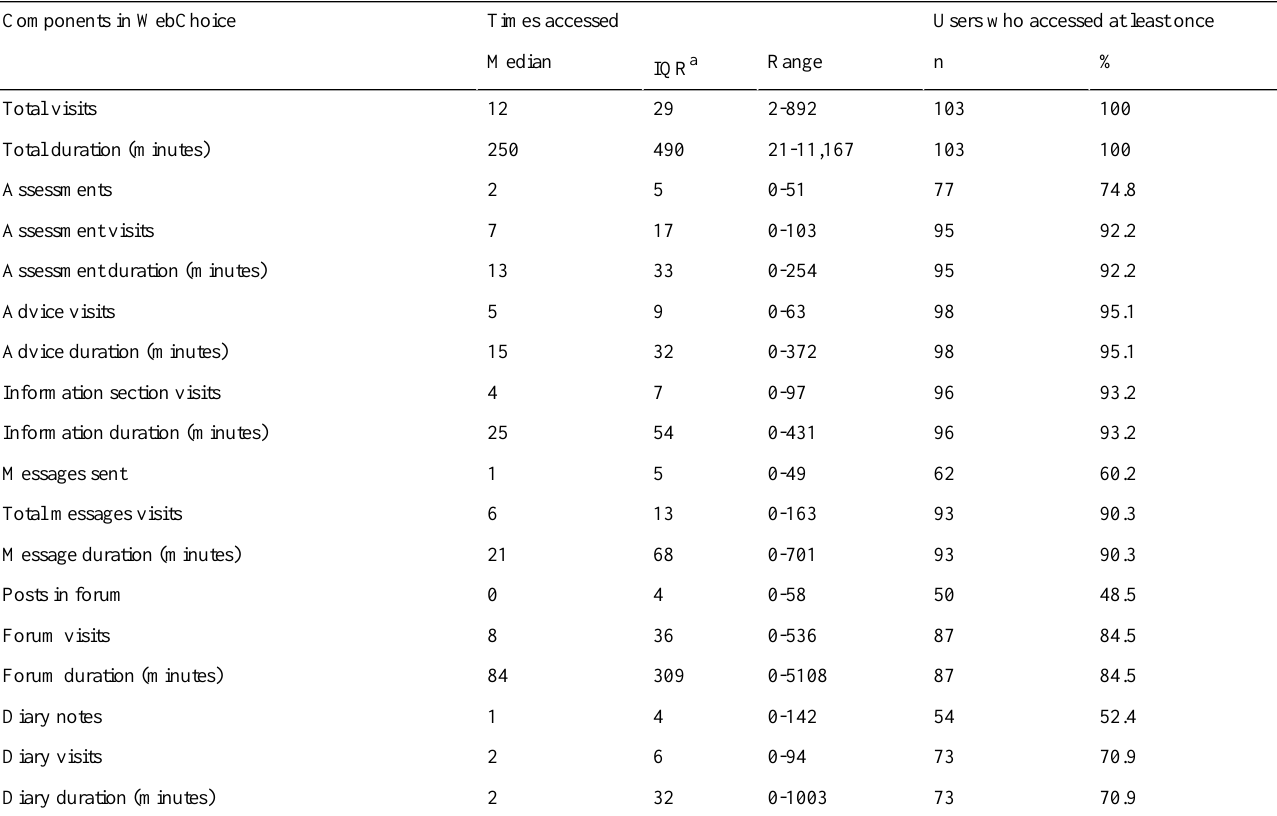
Table 5. Usage of different components of WebChoice over the year of accessibility (N=103).